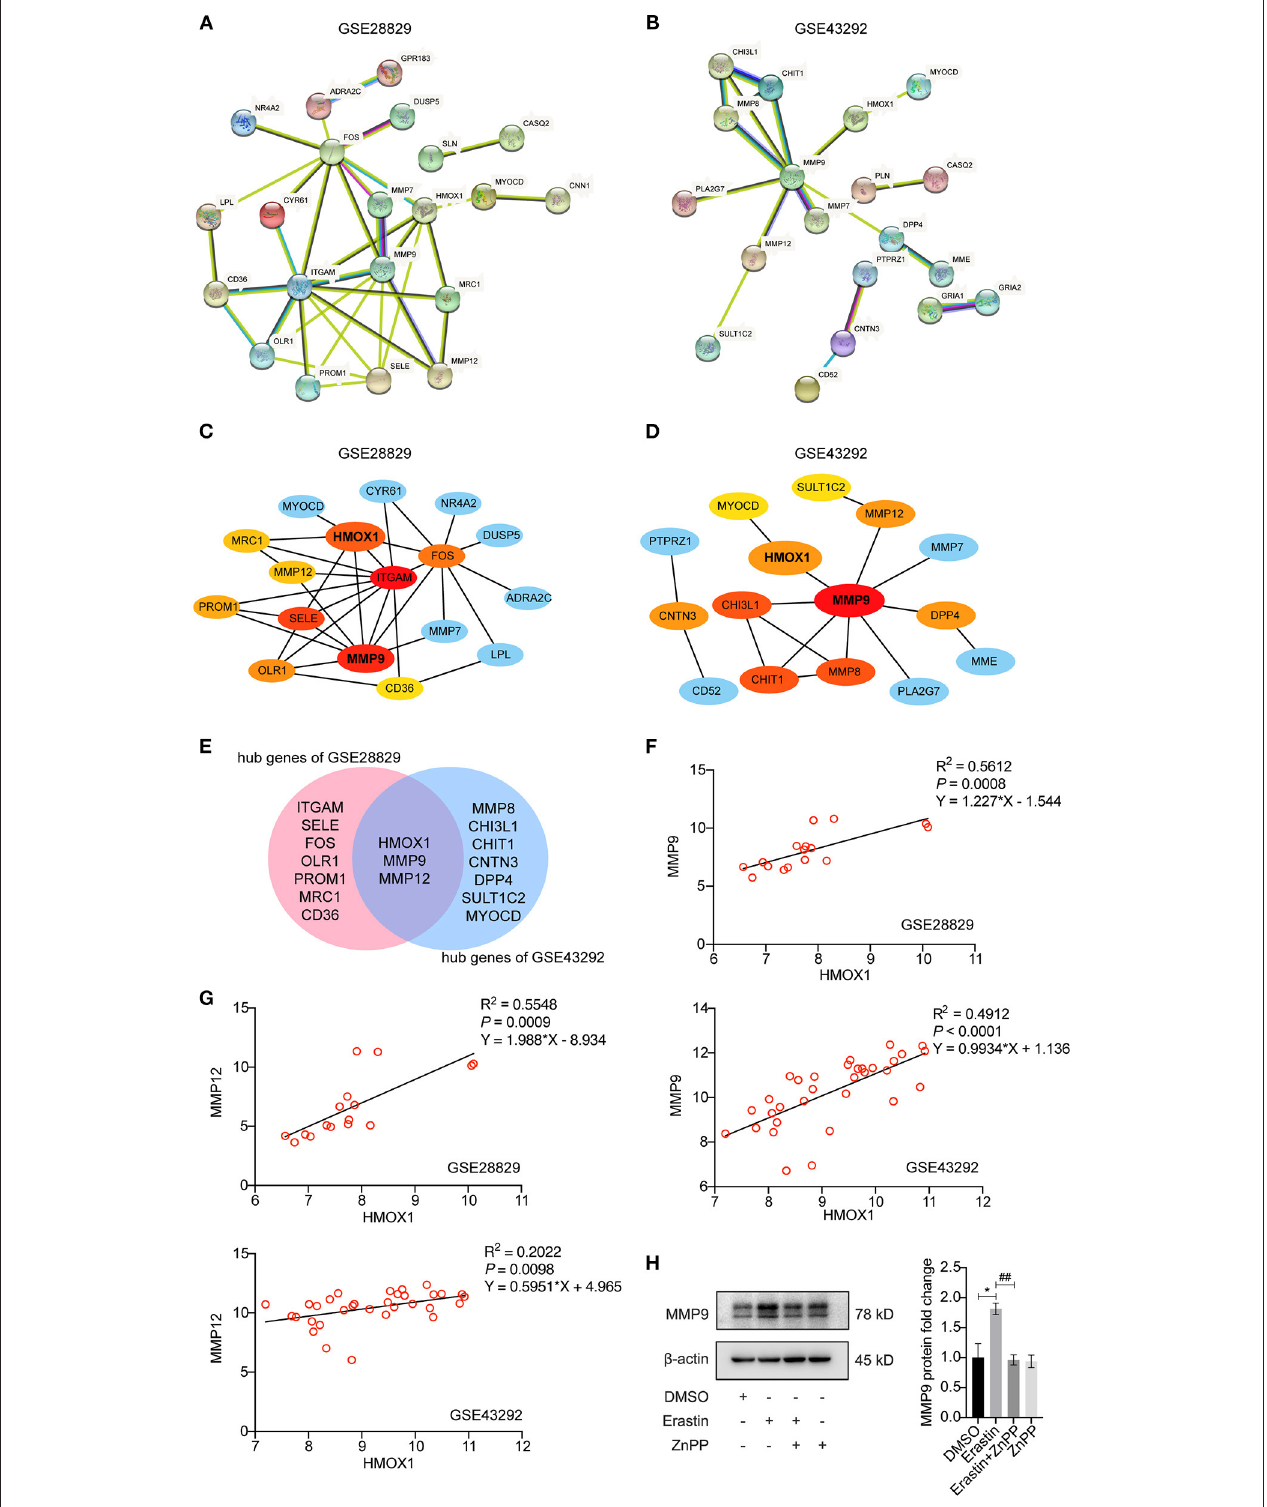
FIGURE 7 | Analysis of protein-protein interaction (PPI) of DEGs in HMOX1 high- and low-expression groups. The PPI networks of DEGs identified between HMOX1 high-expression group and HMOX1 low-expression group in GSE28829 (A) and GSE43292 (B) . The hub genes identified from the PPI networks (C,D) . Venn diagram showing that HMOX1, MMP9 and MMP12 were hub genes (E) . Correlation between HMOX1 and MMP9 as well as MMP12 (F,G) . Representative western blot images and quantitative analysis results (H) of MMP9 after treatment with DMSO (as control), erastin (3 µ M), erastin (3 µ M) combined with ZnPP (5 µ M) or ZnPP (5 µ M). (The error bars represent standard error of mean from three replicates. ## p < 0.01, * p < 0.05, compared between the groups by t -test).